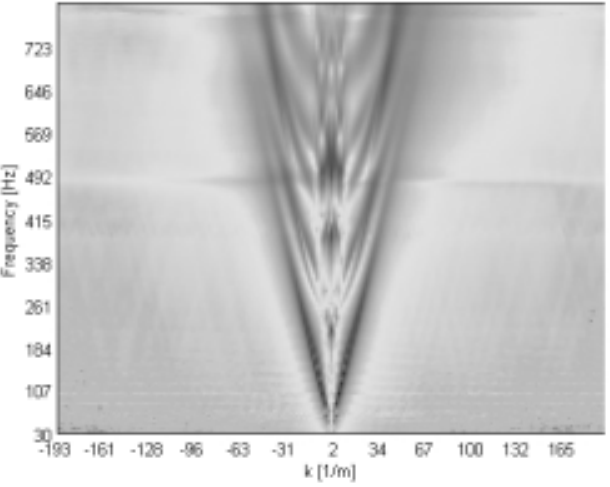
Fig. 11. Diagram k - ω obtained with experimental data for an untreaded truck